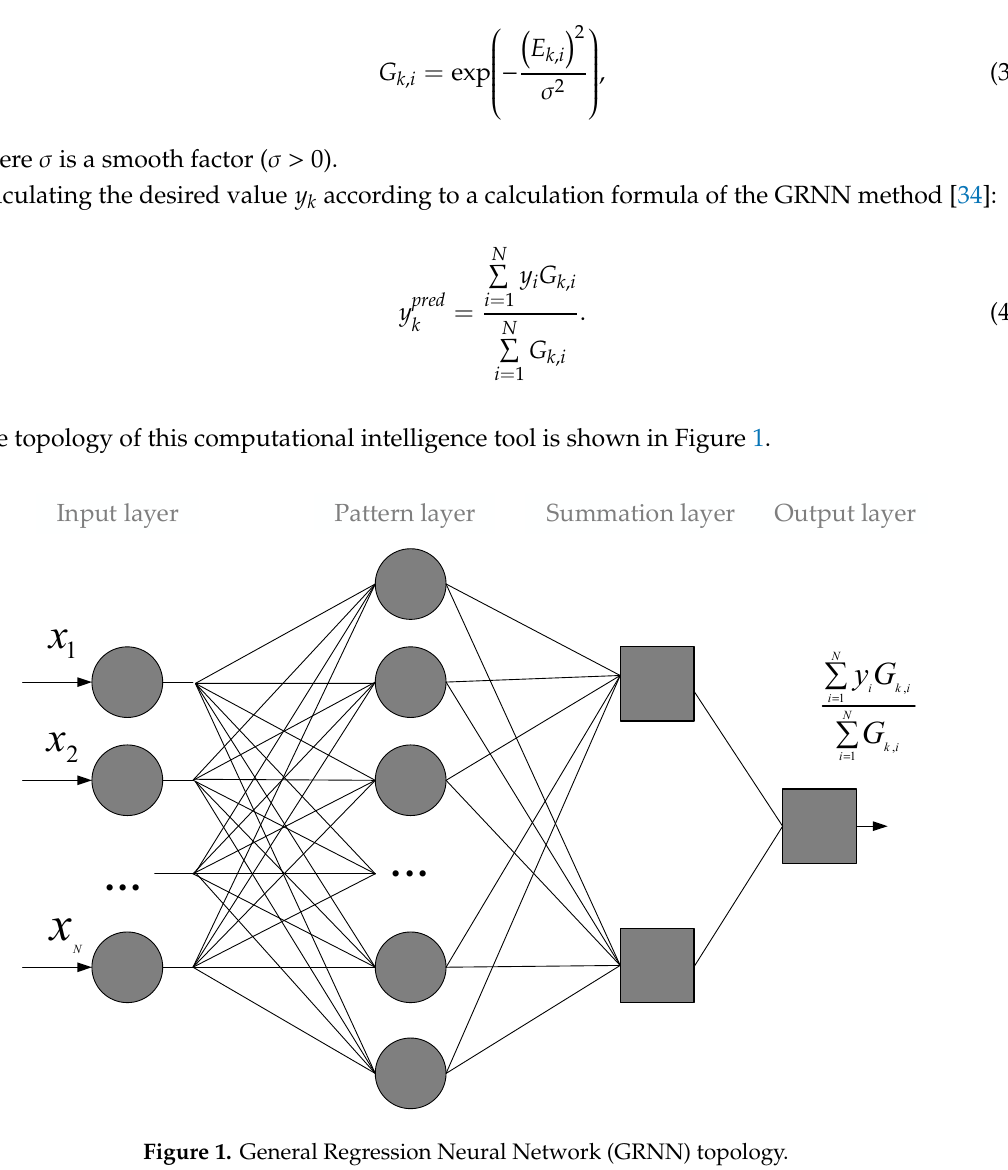
Figure 1. General Regression Neural Network (GRNN) topology.